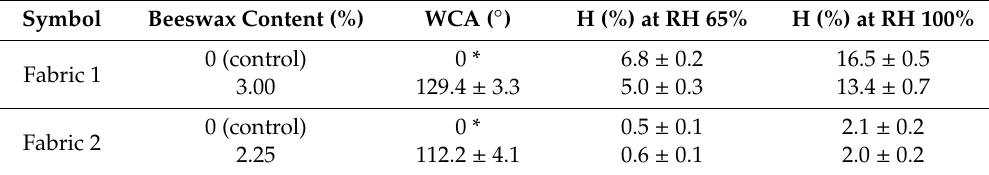
Table 5. Water contact angle (WCA) and hygroscopicity (H) (at di ff erent relative air humidity) of fabrics after modification with beeswax.